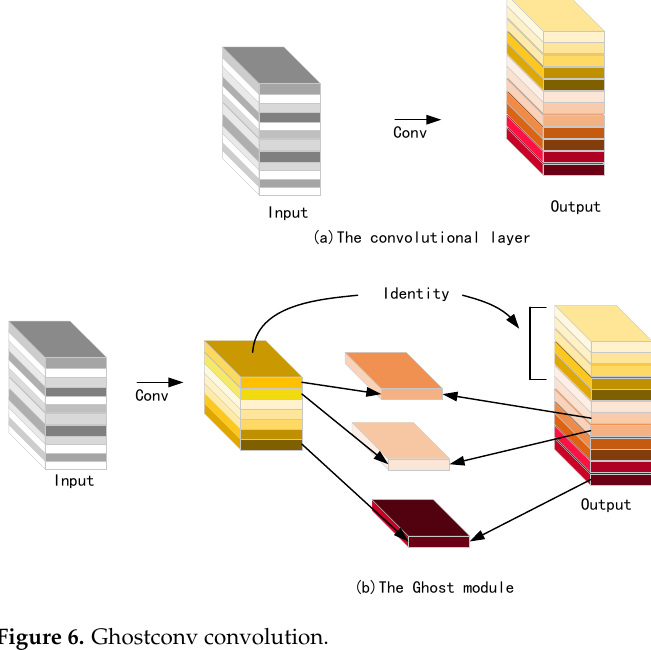
Figure 6. Ghostconv convolution.